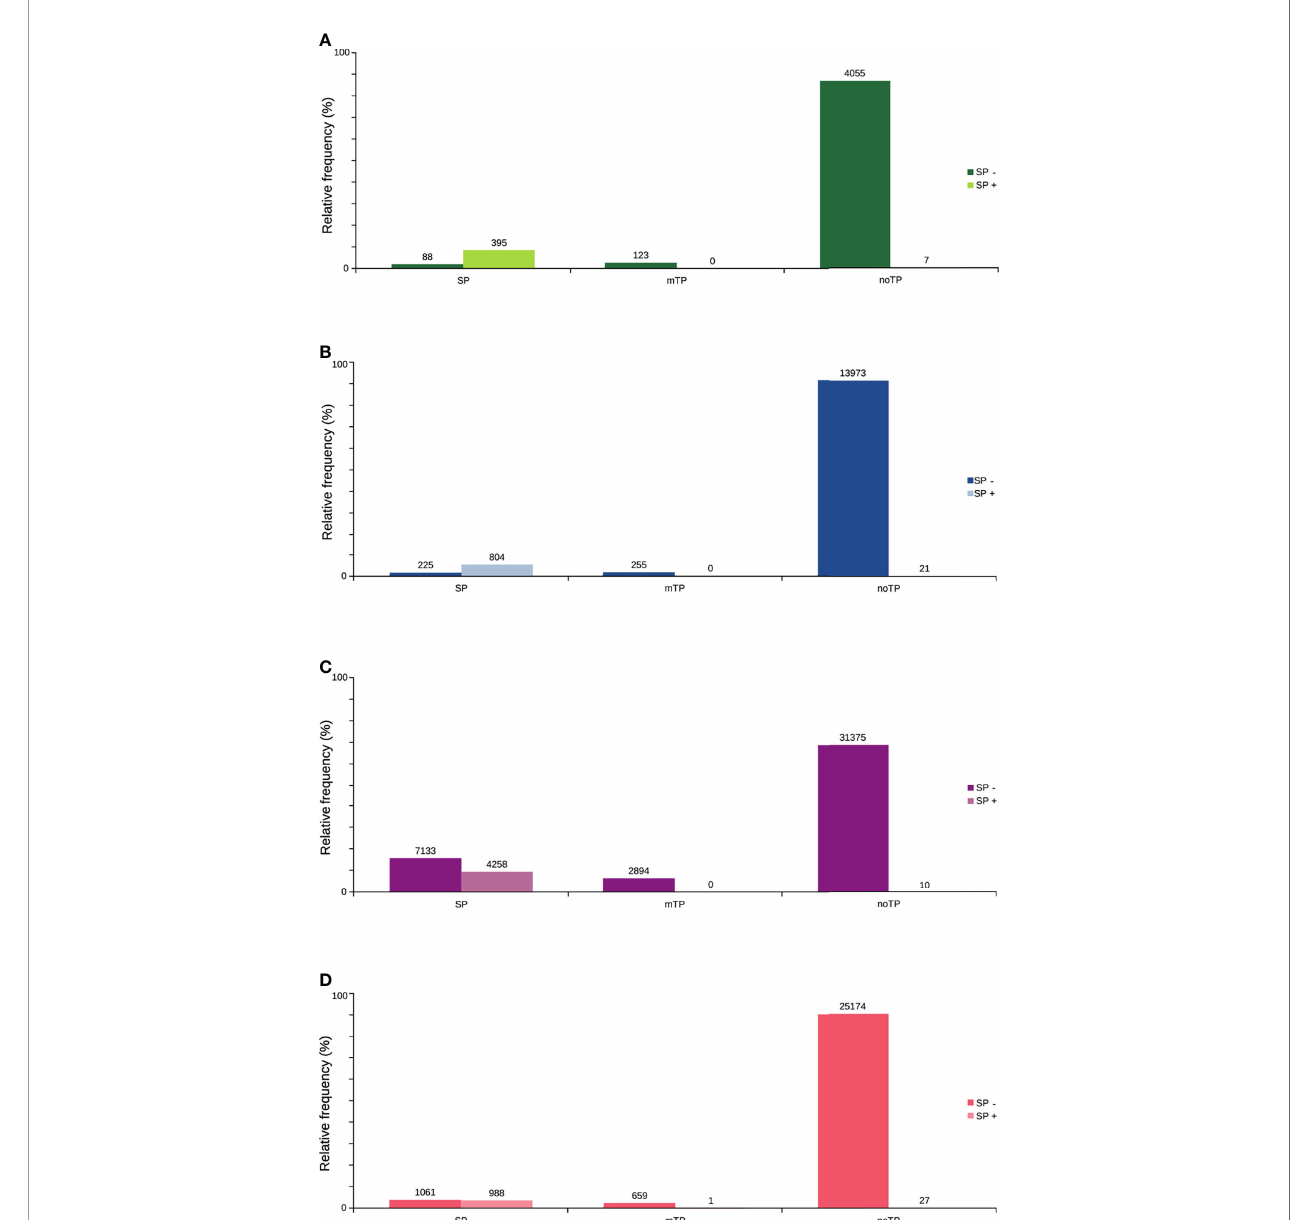
FIGURE 5 | Predicted distribution of ORFs according to the N-terminus predicted by TargetP, with the presence or not of signal peptide (SP+ or SP-) predicted by SignalP. (A) TransDecoder 15,270 (20.7%). (B) Augustus 4668 (6.3%). (C) ORF fi nder (Matched ORF) 27,910 (37.9%). (D) ORF fi nder (Unmatched ORF) 45670 (61.7%). ORFs are capable of addressing mitochondria (mTP); with signal peptide (SP), and without signal or mitochondrial targeting peptide (noTP), according to